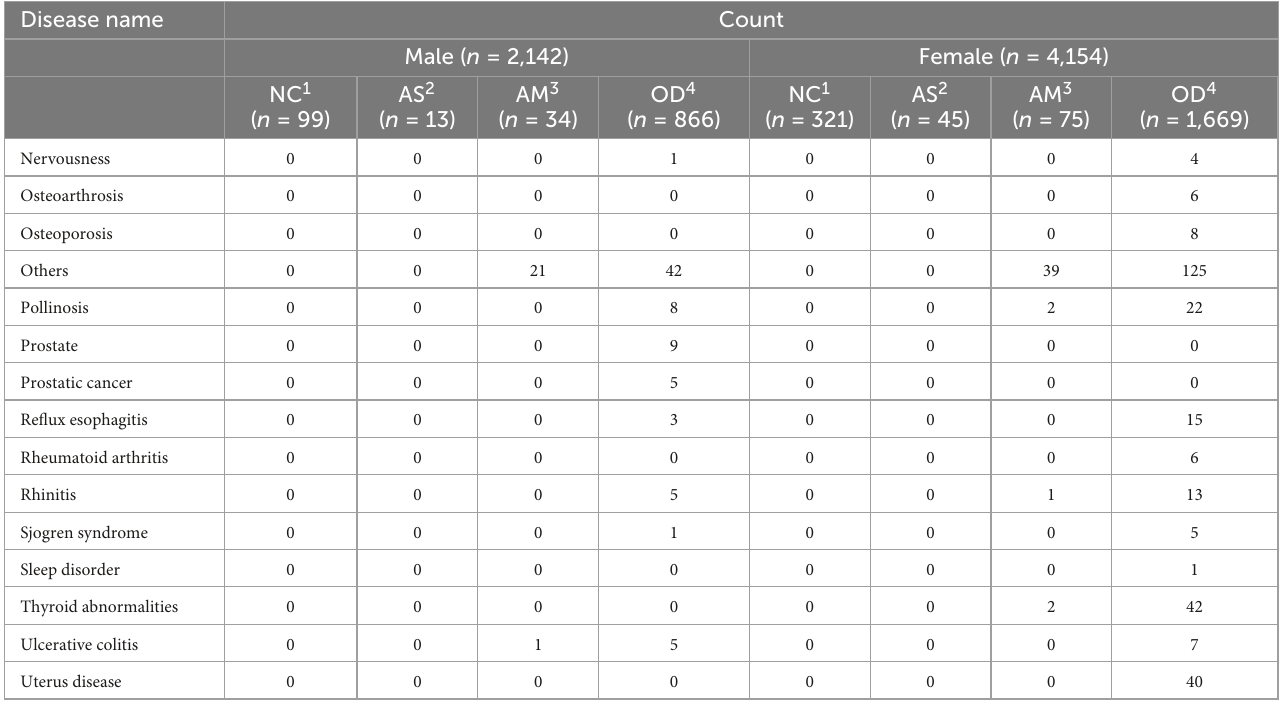
ggsignif package (version 0.6.3; Ahlmann-Eltze and Patil,